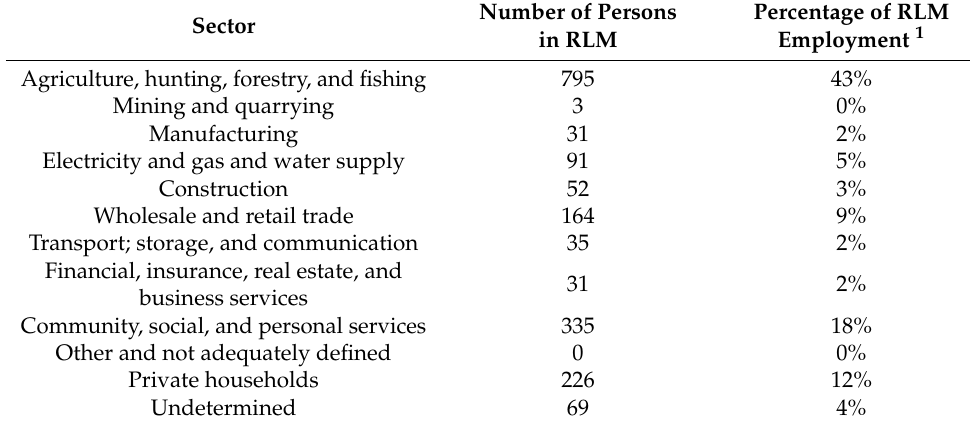
Table 6. Formal employment by sector in 2018/19 in